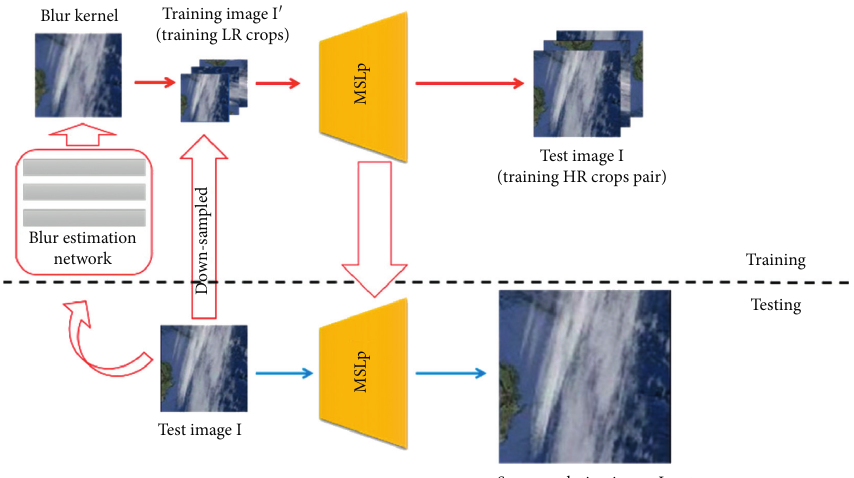
Figure 1: System overview. A proposed small CNN is trained on examples extracted internally from the test image itself. This CNN learns to recover the test image I from its low resolutions with the estimated blur kernel. The resulting unsupervised network is the applied LR image I to predict its